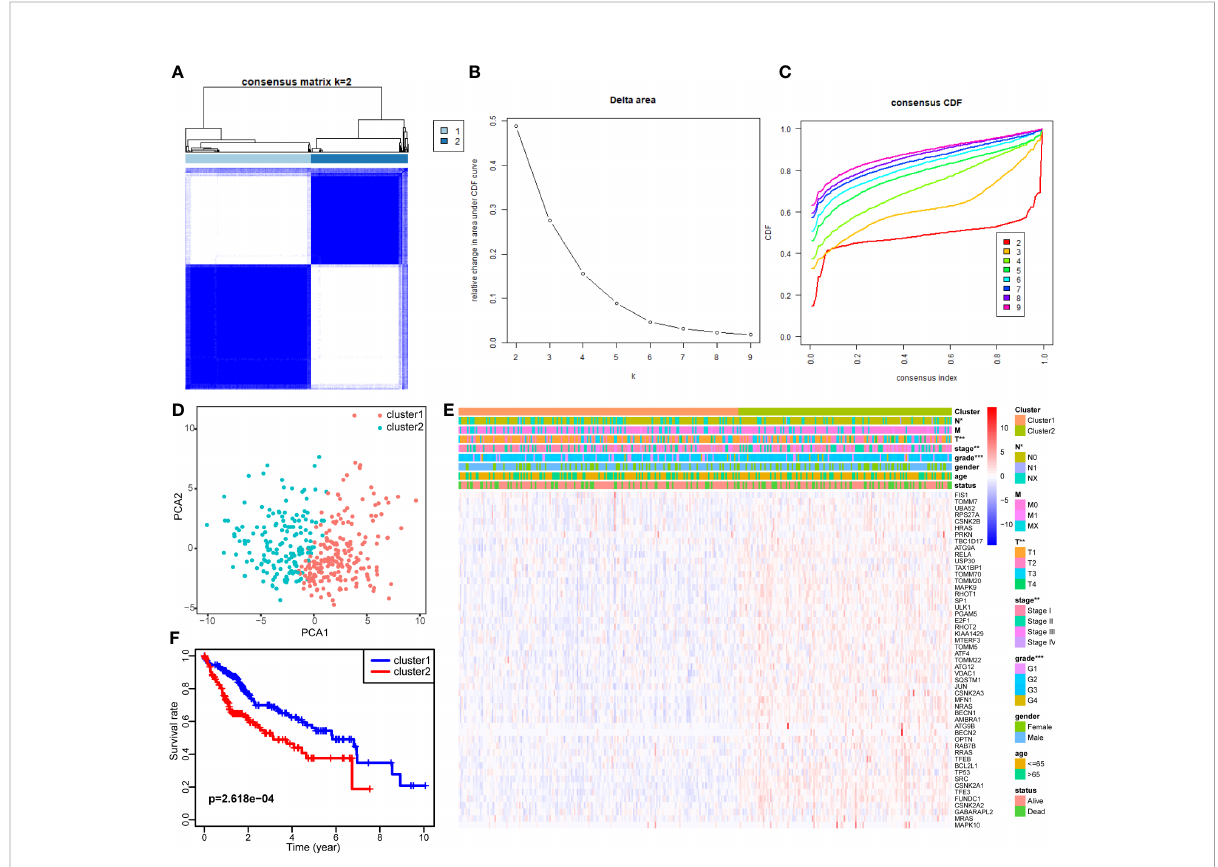
FIGURE 3 Identi fi cation of two mitophagy-related HCC subtypes with different prognosis. (A – C) Consensus matrix of HCC samples co-occurrence proportion for k = 2 (A) , relative change in area under the CDF curve for k from 2 to 7 (B) , consensus clustering CDF for k from 2 to 7 (C) . (D) Principal component analysis of HCC samples grouped by subtype. (E) A heatmap showing the association of mitophagy-related subtypes with clinical characteristics and expression of DEMs. (F) The Kaplan – Meier plot showing the overall survival differences between the two subtypes. The asterisks represent the p value (* p < 0.05; ** p < 0.01; *** p < 0.001). DEMs, Differentially expressed mitophagy-related genes. CDF, Cumulative distribution